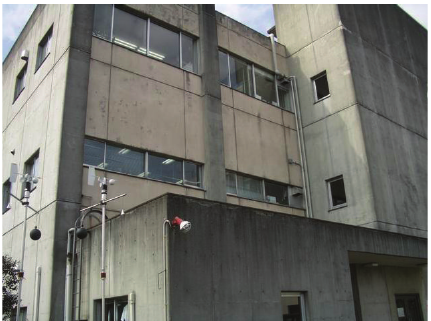
Figure 10: Reinforced concrete building where experiment were conducted.